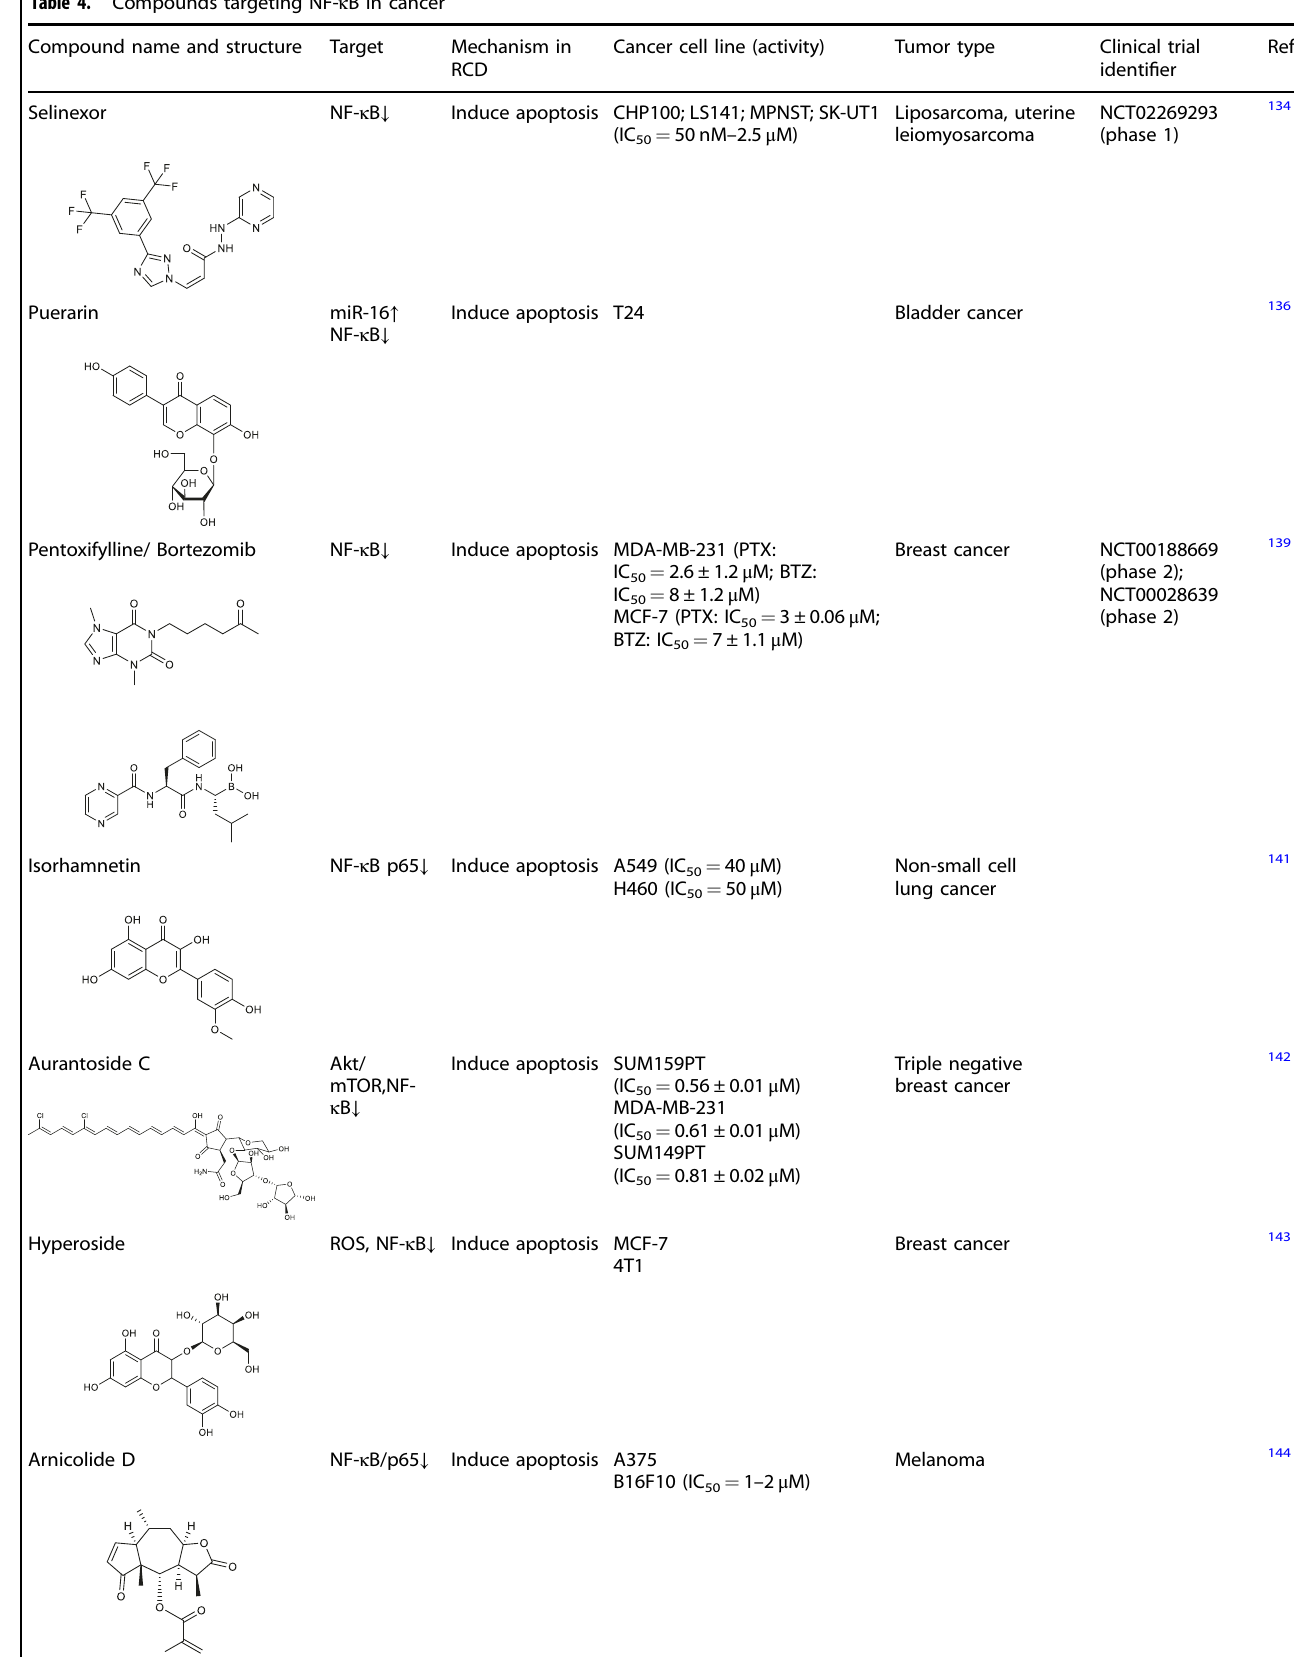
Table 4. Compounds targeting NF- κ B in cancer Compound name and